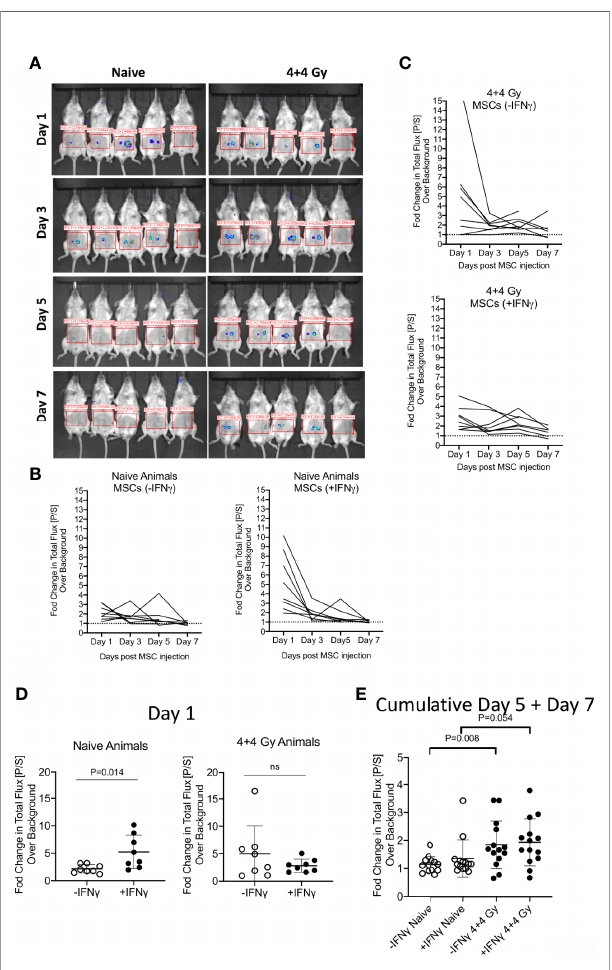
FIGURE 2 | Bioluminescence imaging of +/- IFN g licensed allogeneic MSCs on naive and irradiated animals. (A) Naive or 4 + 4 Gy irradiated animals were subcutaneously injected with +/- IFN g licensed MSCs in each of the fl anks. Bioluminescence imaging was performed in anesthetized animals on days 1, 3, 5 and 7. Each imaging set was performed with 5 animals which are shown as follows. -IFN g MSCs (left two animals) +IFN g MSCs (Middle two animals) Control animal (Rightmost). Total photon fl ux (photons/second) in the region of interest is measured. Fold change in bioluminescence over background is shown longitudinally in (B) Naive and (C) Irradiated animals injected with +/- IFN g licensed MSCs. (D) Changes in total fl ux on day 1 and (E) days 5 + 7 are shown with +/- IFNg licensed MSCs in naive and irradiated animals. Two tailed unpaired t test was performed in GraphPad prism to obtain statistical p values. Results are shown with the cumulative from at least three independent experiments.